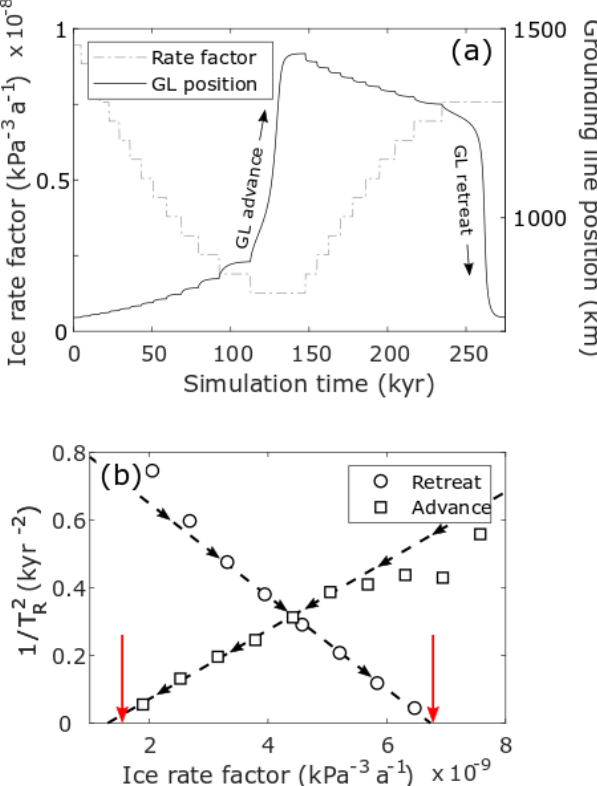
Figure A1. Results of EXP 3, showing change in grounding-line position with time resulting from step perturbations in the ice rate factor (a) . The calculated inverse relaxation time for each corre- sponding step change in rate factor in both the advance (square sym- bols) and retreat (circular symbols) phase is shown in panel (b) . The dashed line in panel (b) is a line of best fit, calculated for the five steps in rate factor that preceded the advance or retreat MISI phase. Red arrows indicate the rate factors for which the analytical solu- tion predicts a MISI event, and black arrows show the direction of the forcing towards each tipping